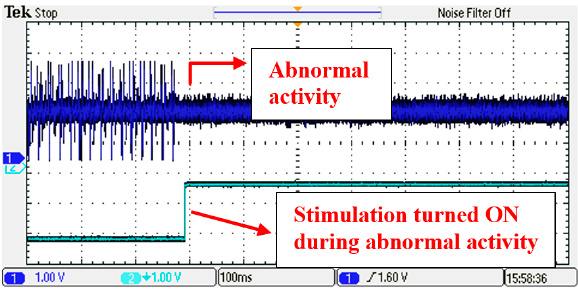
Figure 16. APD output during in vitro validation.